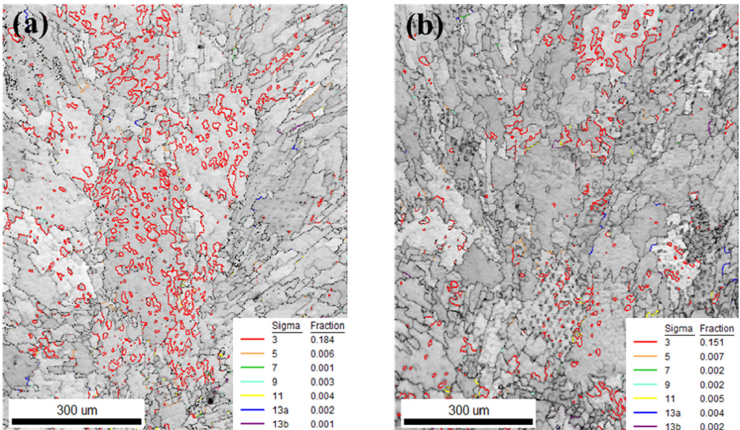
Figure 8. Detailed grain boundary character maps showing the center of the weld bead in the ( a ) underwater laser weld specimen and ( b ) in ‐ air laser weld specimen.